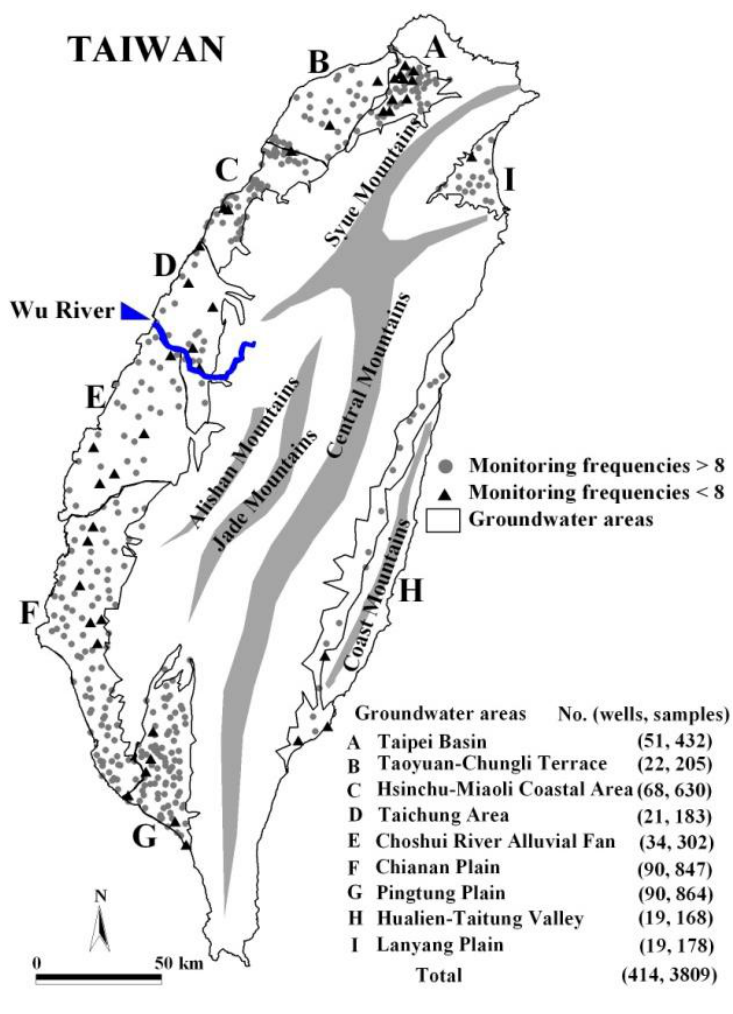
Figure 1. Location of monitoring wells in groundwater